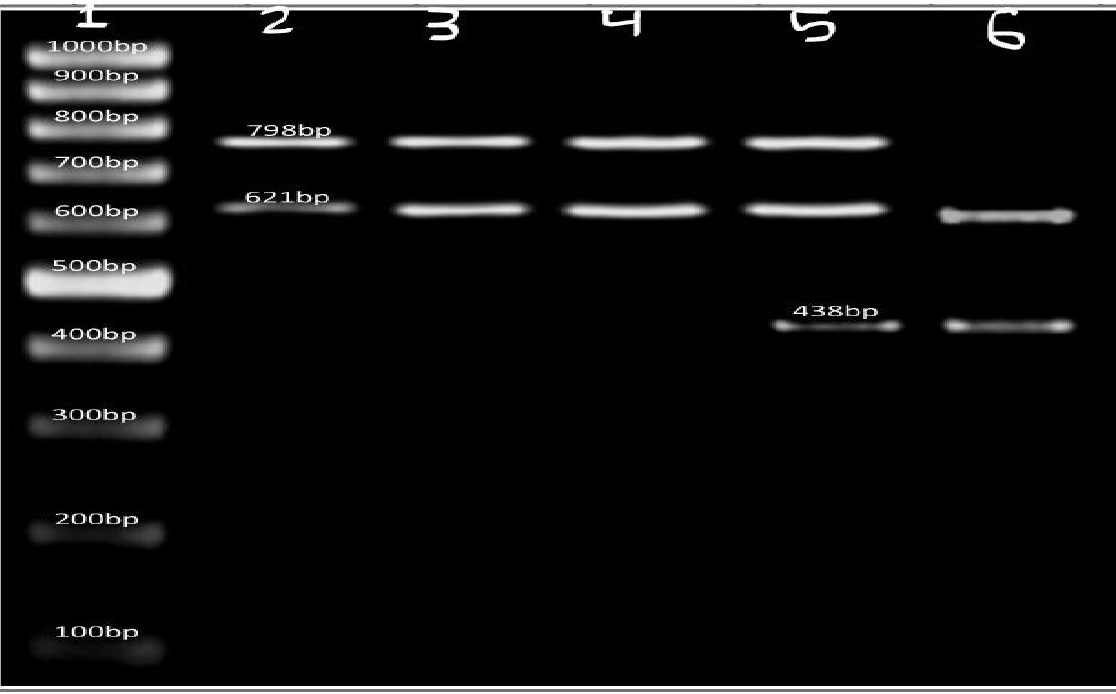
Figure 1. Agarose gel electrophoresis of multiplex PCR for carbapenemase genes detection including bla oxa-48 (438bp), bla NDM-1 (621bp), and bla KPC (798bp), lane 1 DNA ladder100:1000bp, lane 2, 3, 4: +ve for bla KPC and